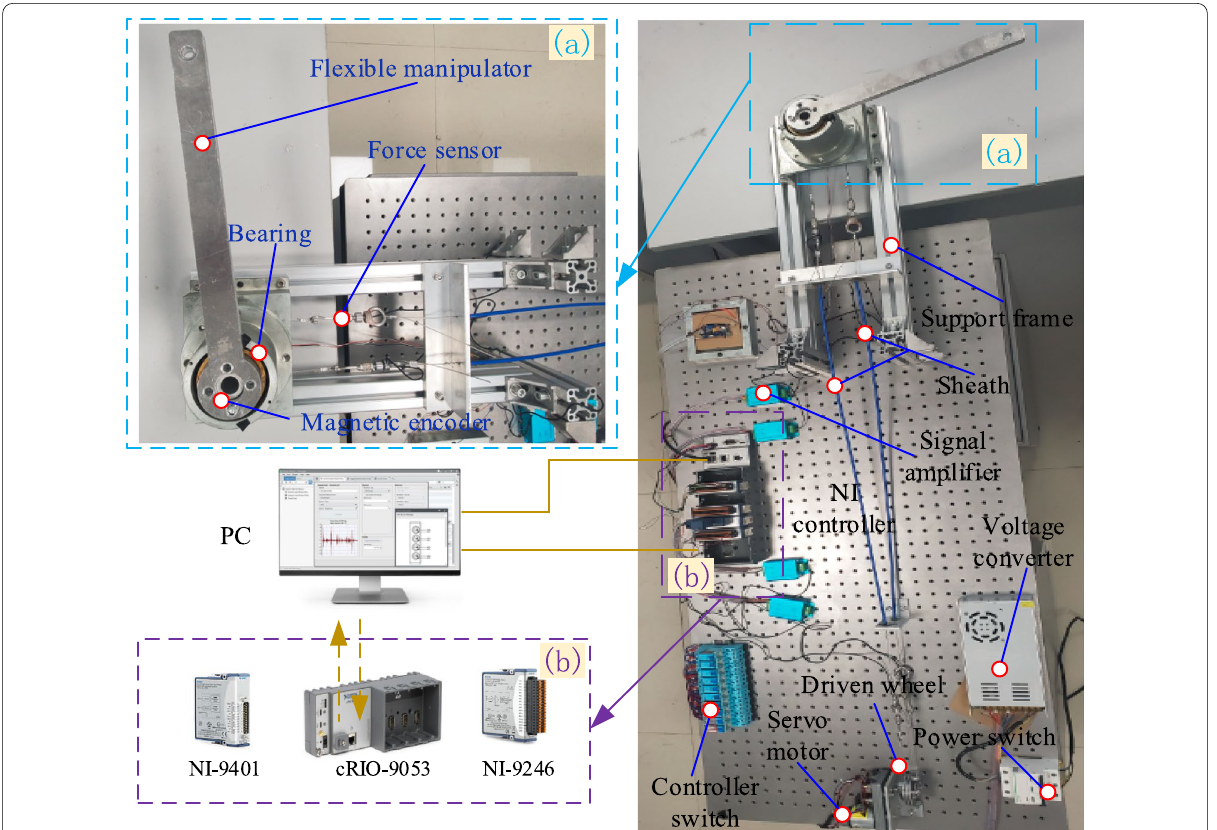
Figure 13 Experimental control platform of the flexible